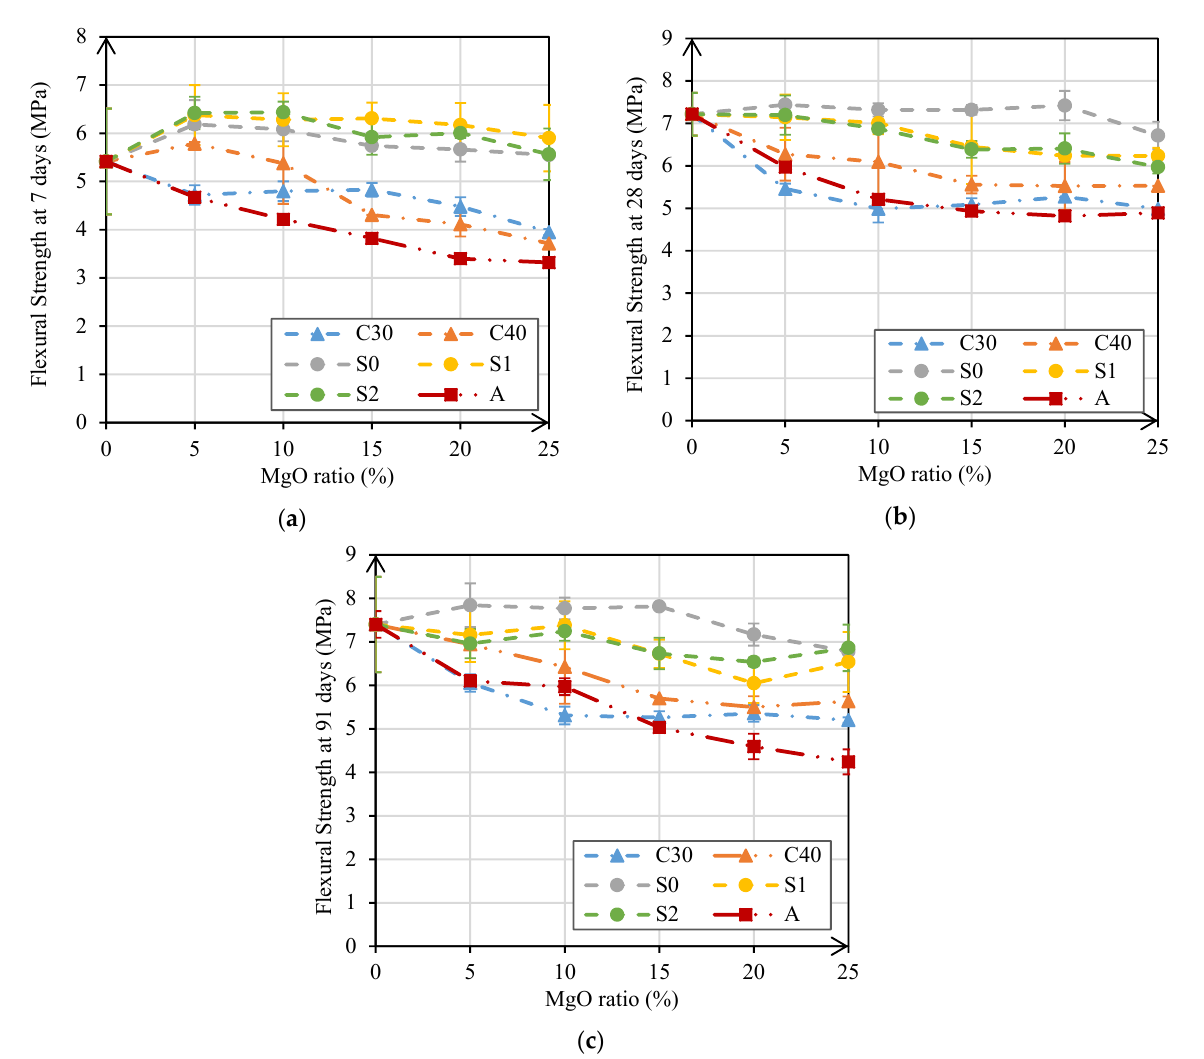
Figure 6. Flexural strength at 7 days ( a ); 28 days ( b ); and 91 days ( c ) versus MgO content. Figure 6b,c shows that, at 28 days and 91 days, the flexural strength of mortars with